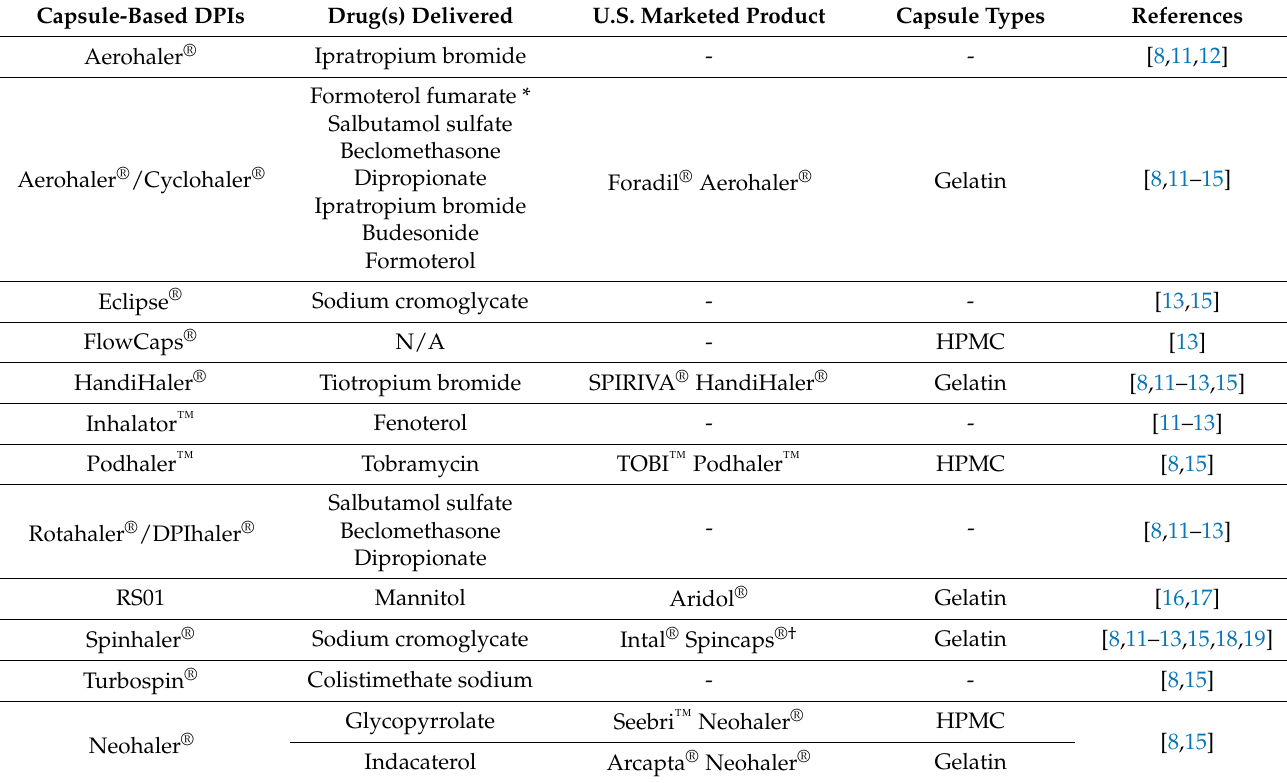
Table 1. Examples of capsule-based DPIs available on the U.S. market and the drug(s) delivered by the device. Included also are the U.S. marketed products that utilize each device (if any) and the capsule in the FDA-approved formulation. Capsule-Based